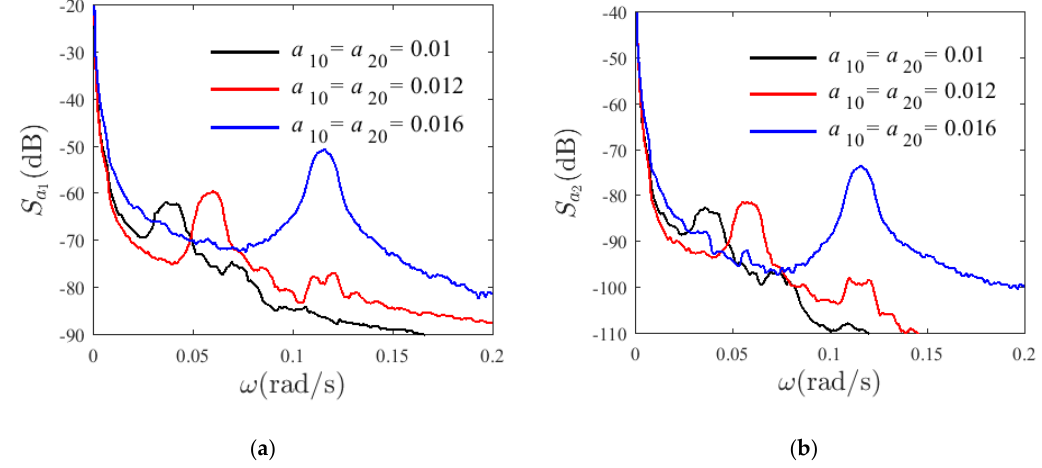
0.2 ); ( a ) a . Figure 3. PSD curves of variation modes for different initial conditions a ( γ 0 = 0.2 π ); ( a ) a 1 , ( b ) a 2 0 2